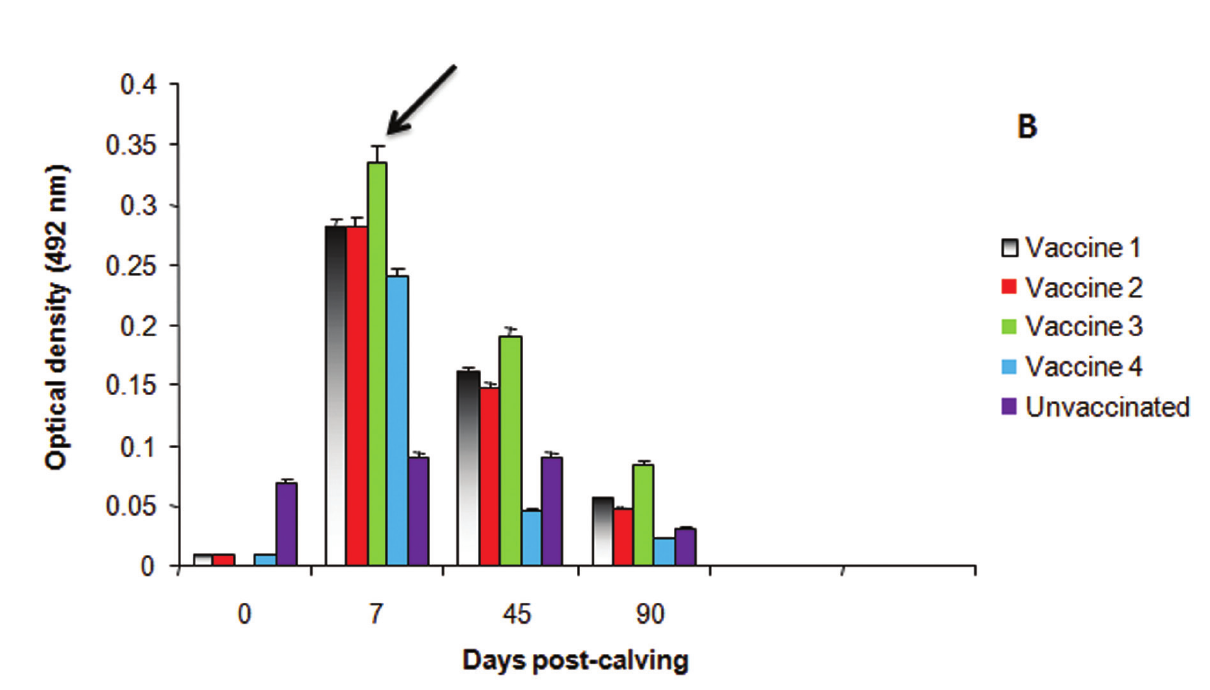
Figure 1. Neonatal passive immune response from beef calves obtained from vaccinated pregnant cows against Clostridium botulinum toxoids C and D with four commercial vaccines (vaccines 1, 2, 3, and 4), measured by indirect ELISA using ( A ) holotoxins C and ( B ) D as capture antigens. Standard deviations were below 5% of mean values of four independent measurements and are shown in the figure. Highest antibody levels are shown by